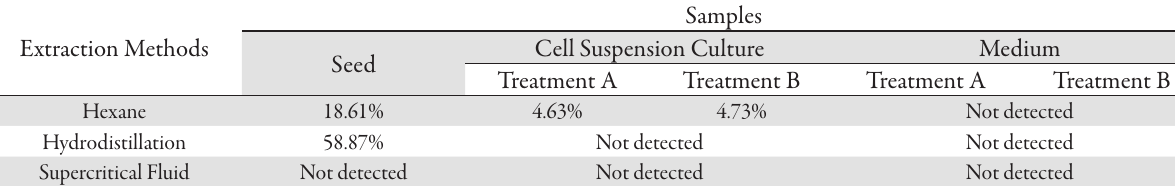
Fig. 4. GC chromatogram of the cuminaldehyde standard (Arrow shows the cuminaldehyde pick) Tab. 1. Comparison of cuminaldehyde percentage in seed, cell suspension cultures and medium of Bunium persicum in three extraction